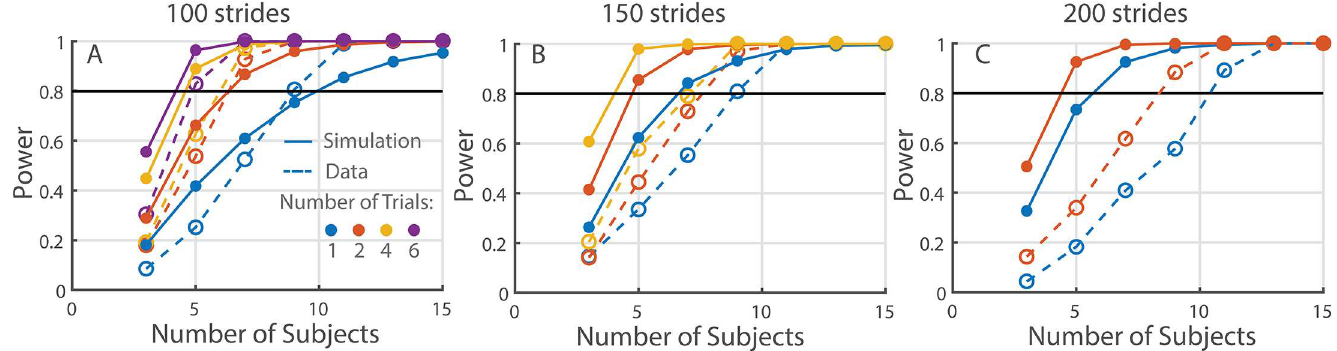
Fig 3. Comparison of power predictions (solid lines) with the experimentally observed power (dotted lines) for different trial lengths. (A) 100, (B) 150, and (C) 200 strides. Coloredlines indicatethe number of trials used per subject: 1 (blue), 2 (orange),4 (yellow), and 6 trials (purple).